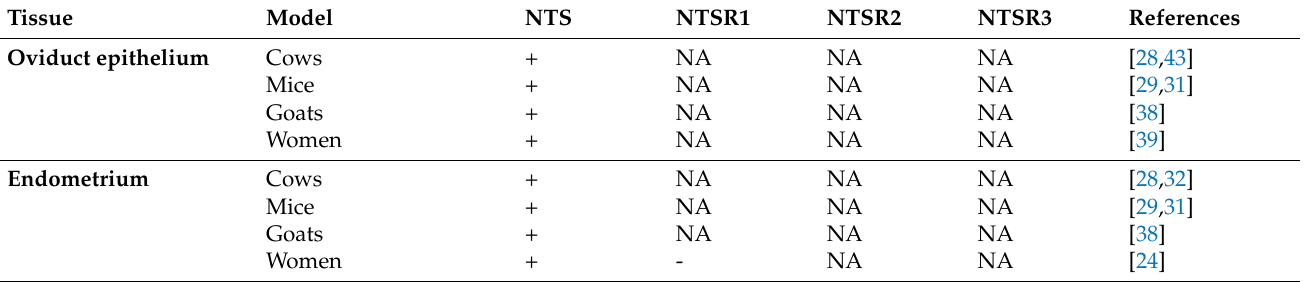
Table 1. Physiological expressions of NTS and its receptors in reproductive system in mammalians.